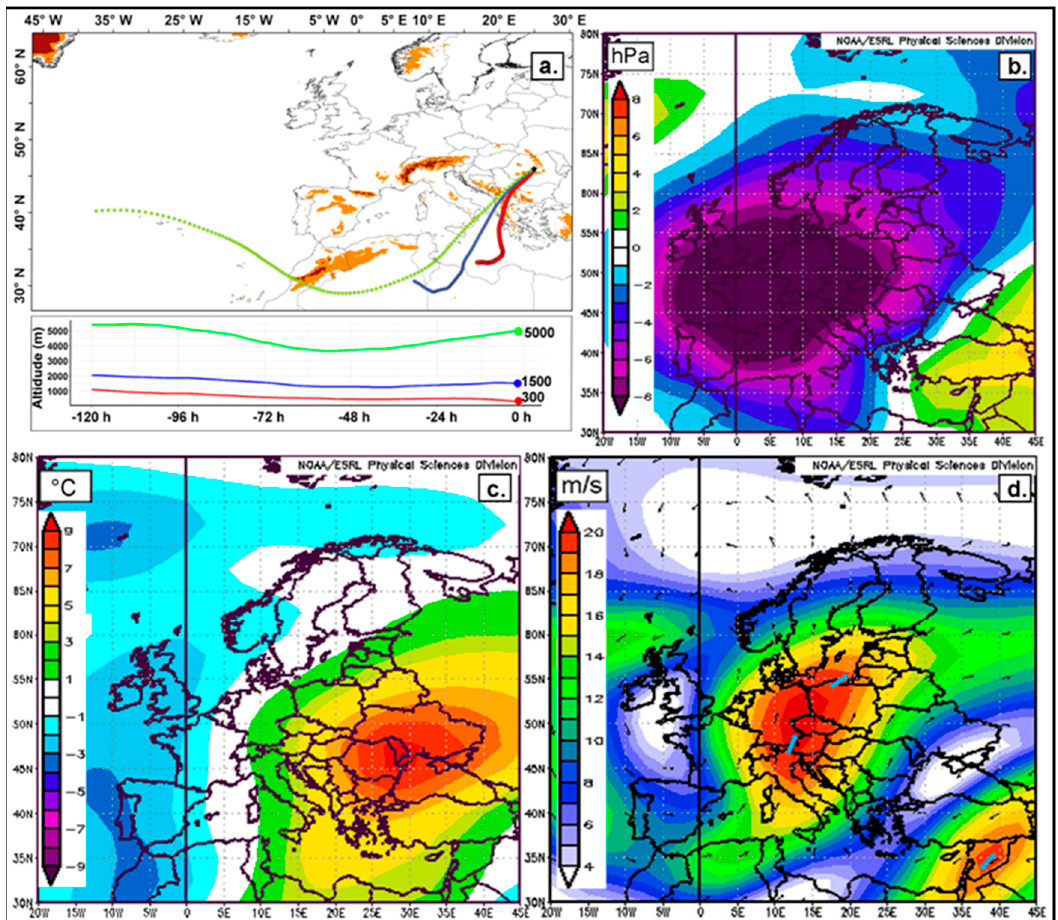
Figure 4. ( a ) Mean five-day backward trajectories of air particles before the first day of B1